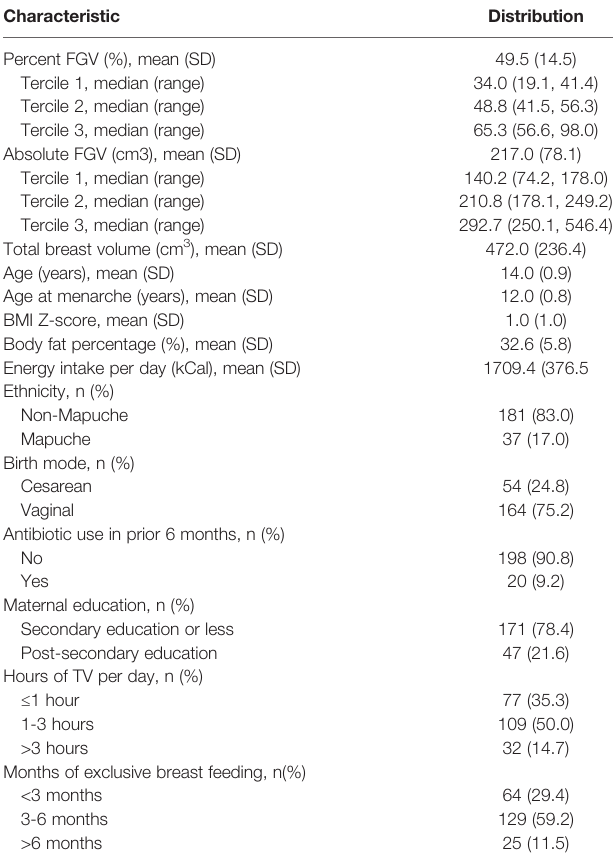
TABLE 1 | Population characteristics of 218 girls participating in the Growth and Obesity Cohort Study. Characteristic